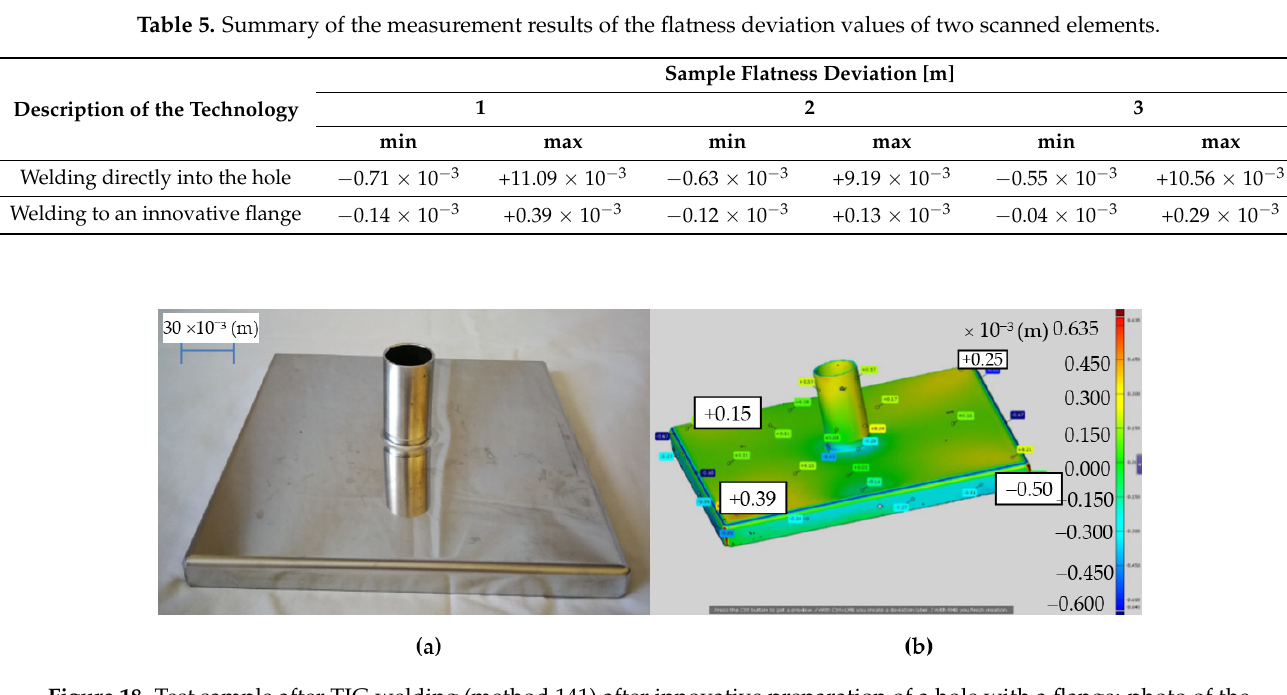
Figure 18. Test sample after TIG welding (method 141) after innovative preparation of a hole with a flange: photo of the real object ( a ), virtual model after 3D scanning with the ATOS III scanner with measurement results ( b ).